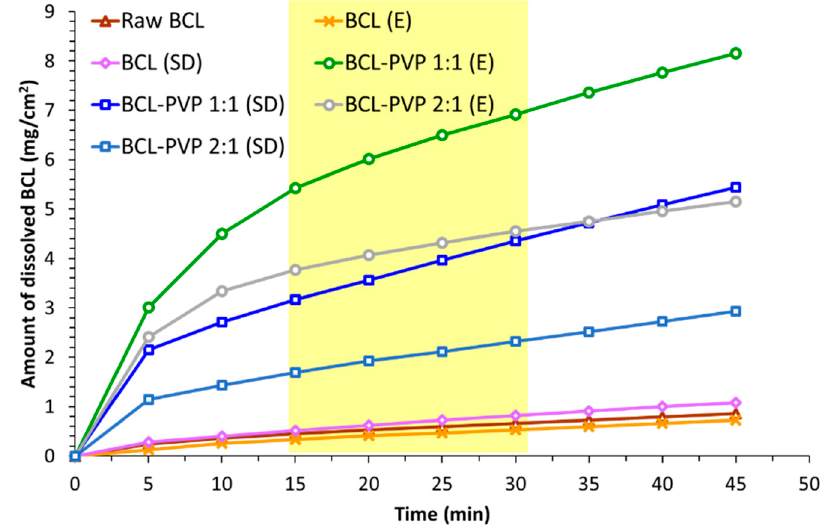
Figure 9. Intrinsic dissolution of crystalline bicalutamide, drug processed alone and binary systems containing bicalutamide and PVP obtained using the evaporation technique (E) and spray drying (SD). Yellow square indicates the range used to calculate the intrinsic dissolution rate (IRD) values.